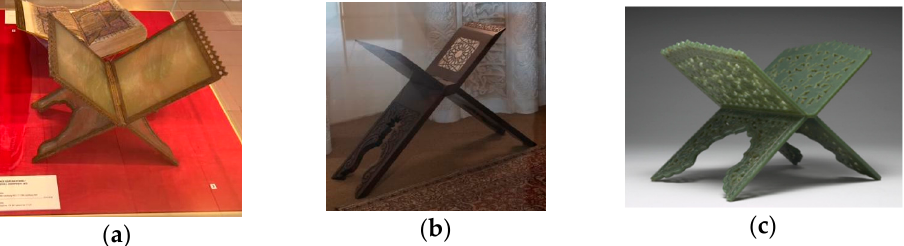
Figure 2. Rehal from ( a ) India, ( b ) Egypt, and ( c ) Mongolia, respectively (Photos source: ( a , b ), taken by the researcher in Islamic Arts Museum Malaysia, KL).